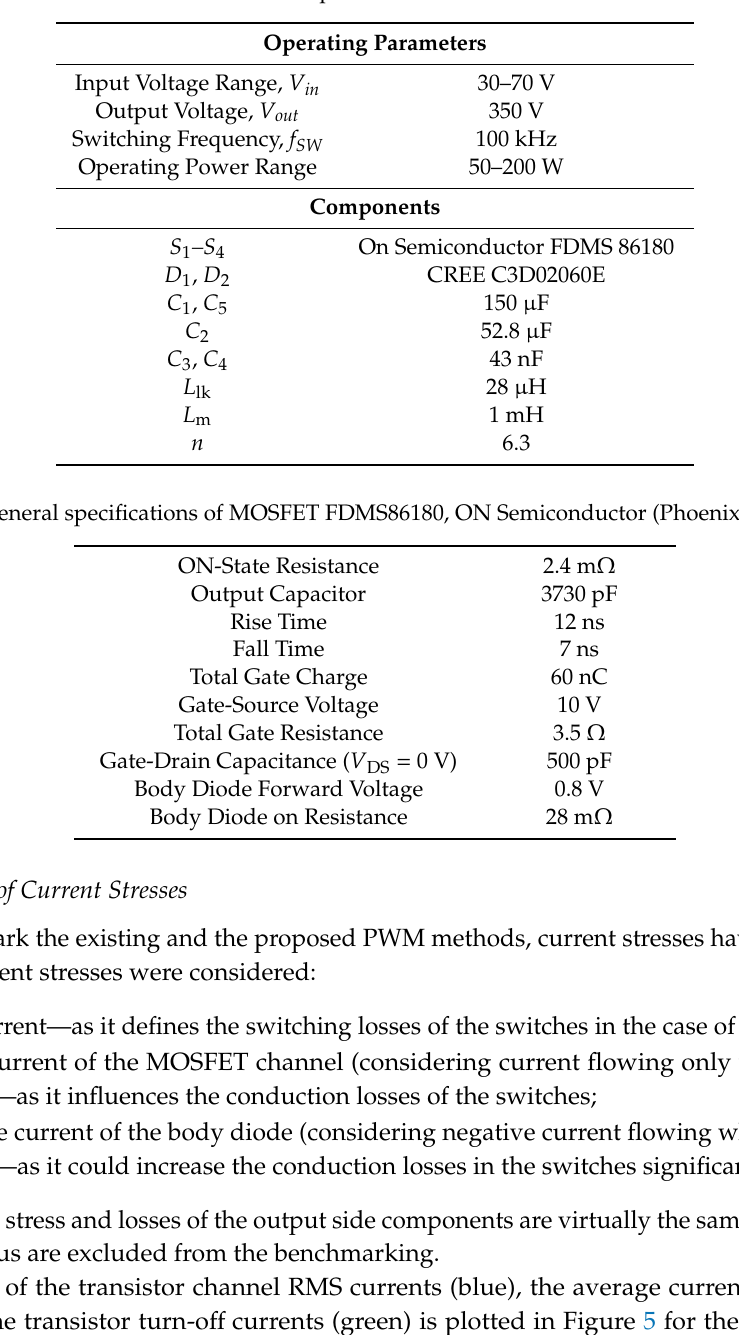
Table 1. General specifications of the converter.